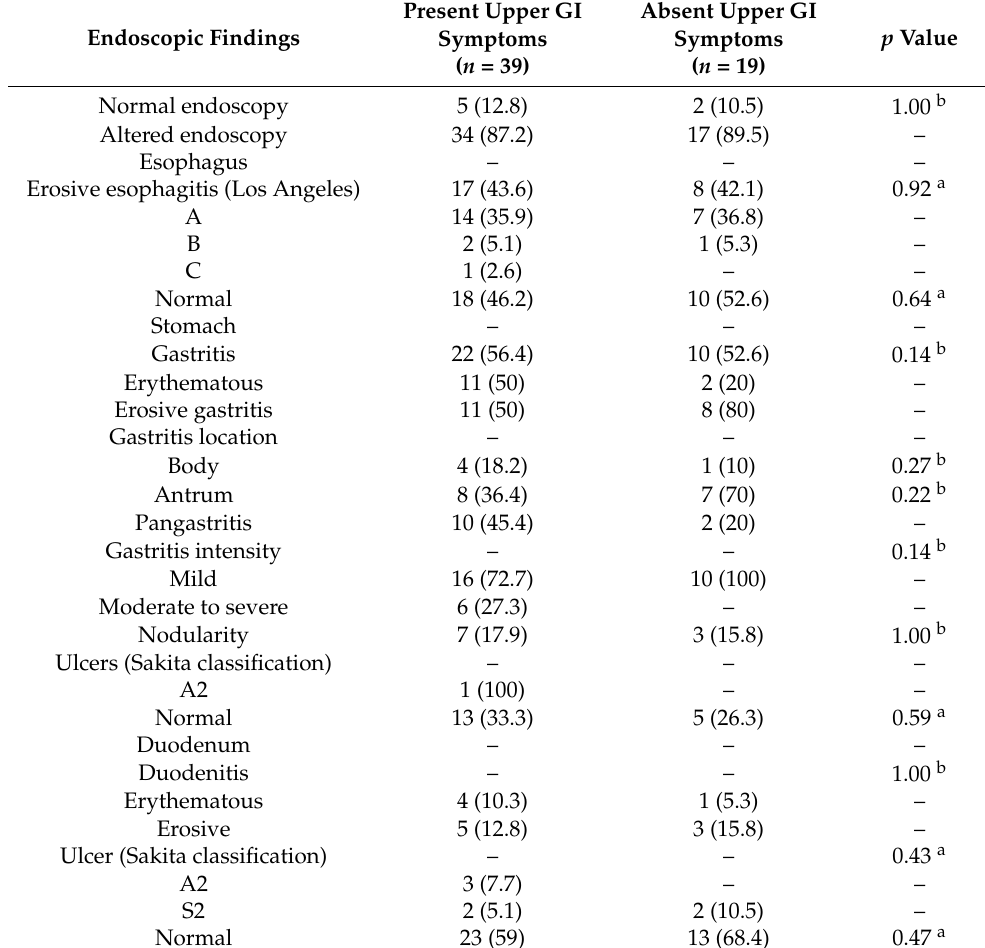
Table 2. Endoscopic Findings in Patients with CD According to the Presence of Upper GI Symptoms.